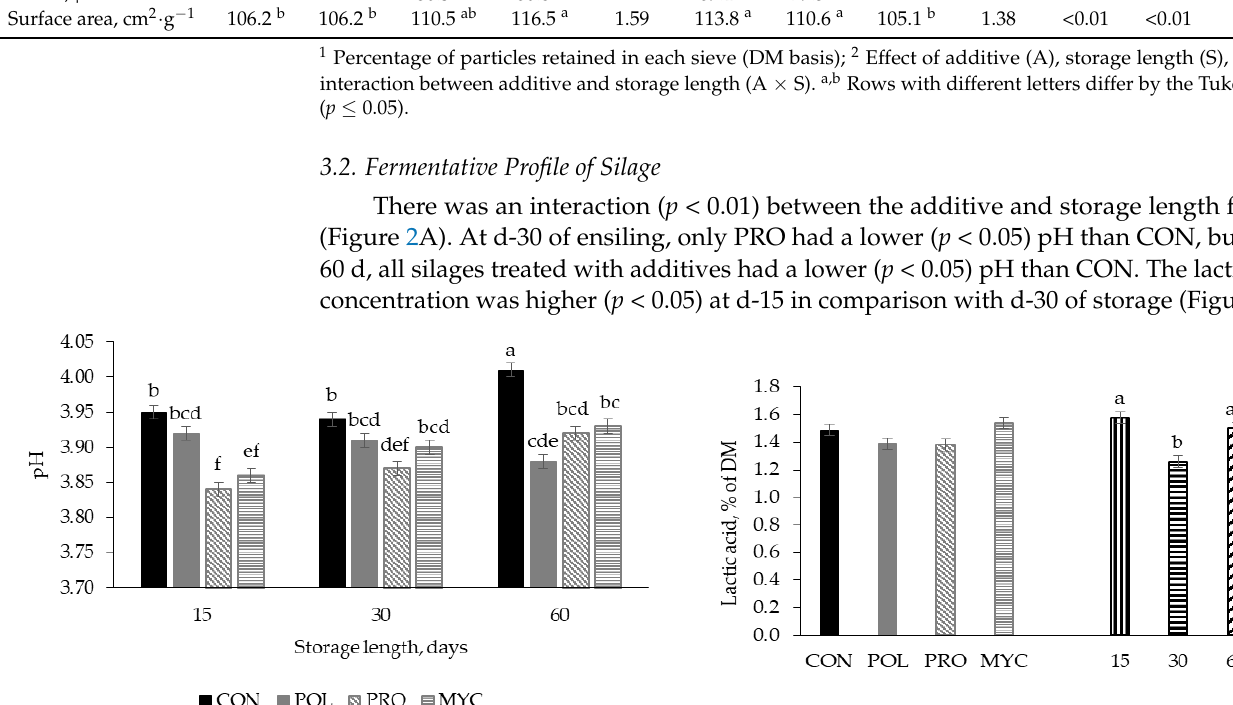
Figure 2. pH-value and lactic acid content of reconstituted corn grain silage ensiled for 15, 30 or 60 d, without additives treatment (CON), or treated with polysorbate 80 (POL), propionic acid (PRO) or polysorbate 80 and propionic acid (MYC). Statistical effects observed for ( A ) pH – Additive, p < 0.01; Storage, p < 0.01; A × S, p < 0.01, SEM = 0.01; ( B ) Lactic acid – additive, p = 0.56, SEM = 0.09; Storage, p = 0.02, SEM = 0.08; A × S, p = 0.33. Different letters differ by Tukey’s test ( p ≤ 0.05). Figure 3 summarizes the values of acetic acid (3A) and ethanol (3B), respectively, an important antifungal agent and a product of yeast metabolism. The POL showed lower values, PRO showed the same and MYC had a higher concentration of acetic acid compared to CON ( p < 0.05). There was an interaction ( p < 0.01) between the additive and the storage length for ethanol content. At d-30, only POL and PRO had a lower ( p < 0.05) ethanol concentration than CON, but at 60 d, all treatments, including MYC, had a lower ( p < 0.05) ethanol concentration than CON.